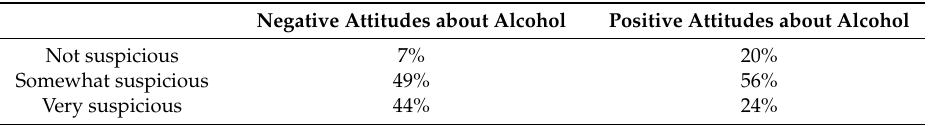
Table 2. Suspicion about someone leading away an intoxicated person from a party & Attitudes about